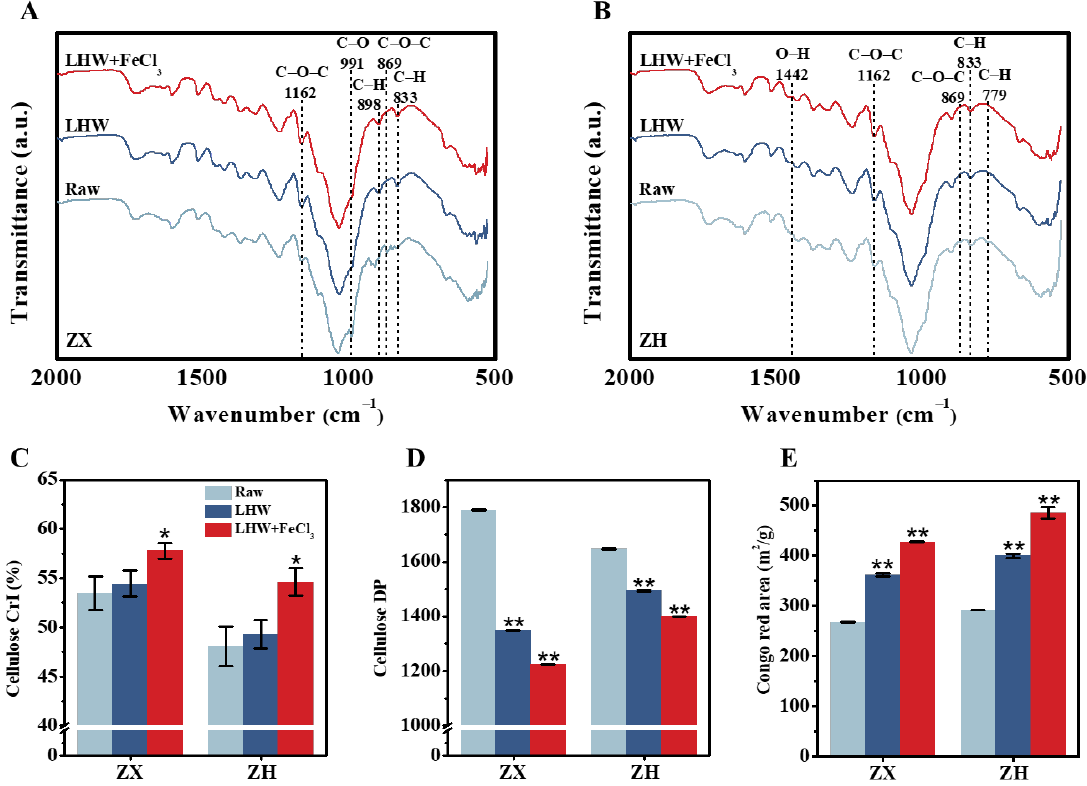
Figure 2. Characterization of wall-polymer linkages and cellulose features after optimal LHW pretreatment co-supplied with 4% FeCl3 in two corn cultivars. ( A , B ) Fourier transform infrared (FT-IR) spectroscopic profiling, as annotated in Table S1; ( C , D ) cellulose CrI and DP; ( E ) cellulose accessibility by Congo red staining. Data as mean ± SD ( n = 3); * or ** a significant difference between pretreated residue and raw material at p < 0.05 or 0.01 level.